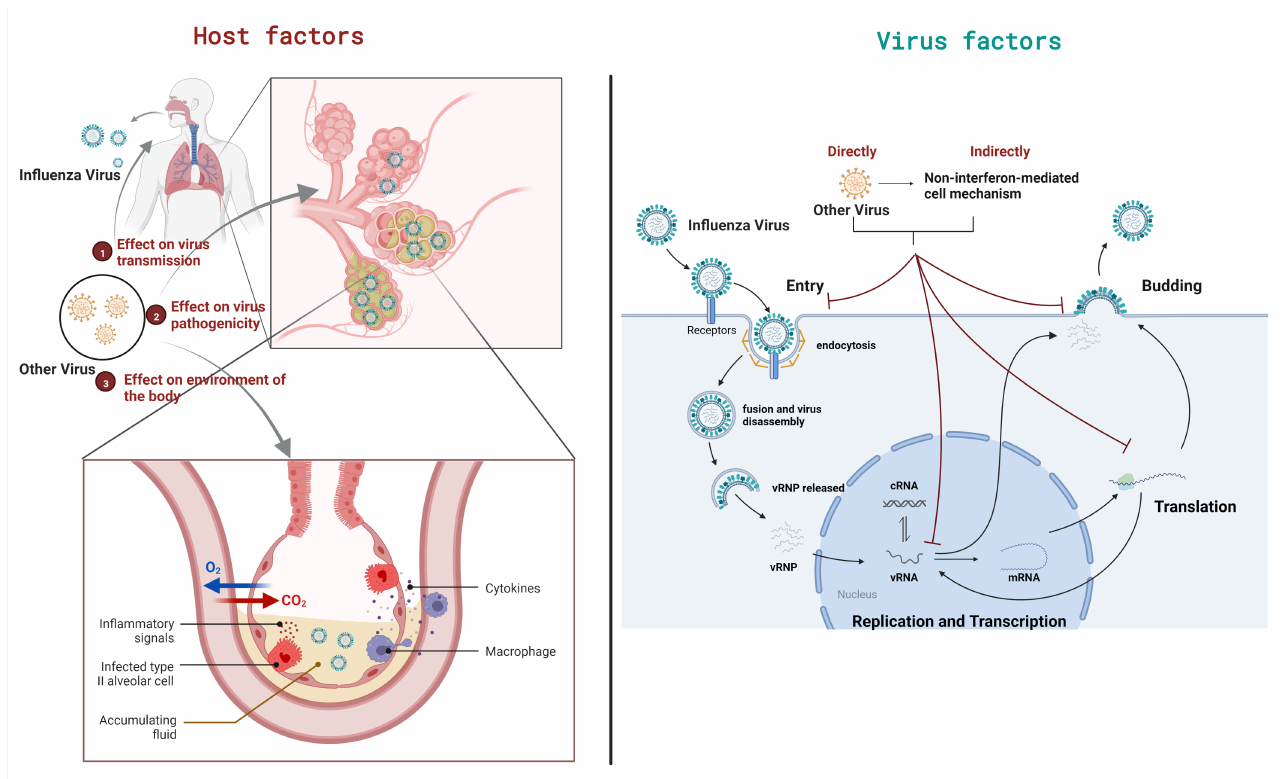
Figure 1. Two factors leading to the outcomes of viral coinfection. The outcomes of viral coinfection can be mainly attributed to two factors, namely virus factors and host factors. The figure takes IAV coinfection as an example. Host factors in coinfection change the environment of the body, thereby affecting the transmission and pathogenicity of viruses. Virus factors are coinfection changes that affect the intracellular environment and directly or indirectly affect the viral life